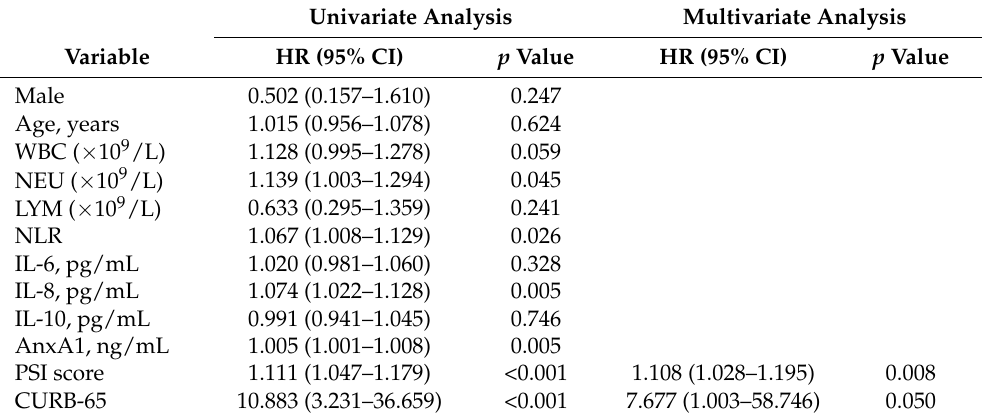
Table 3. Binary logistic regression analysis for SCAP incidence.